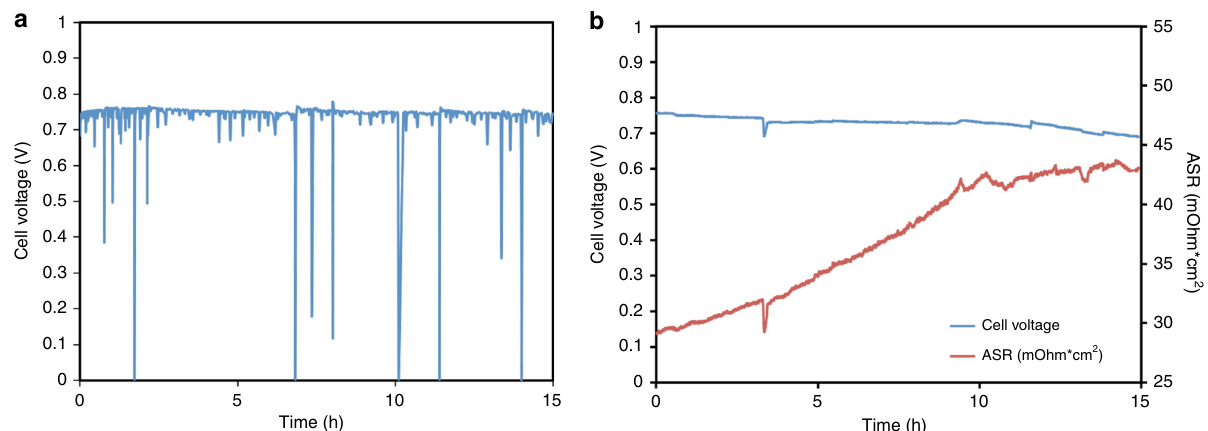
Fig. 5 AMFC stability at high and low water conditions. a Cell stability under relatively high anode/cathode dew points of 55/60 °C; ( b ) cell stability under optimized anode/cathode dew points of 53/55 °C. During the test, the cell voltage and ASR were recorded. The cells were constructed with a PtRu/C anode at 0.70 mg PtRu cm − 2 , a Pt/C cathode at 0.60 mg Pt cm − 2 , and a radiation-grafted ETFE-based AEI powder ionomer and HDPE-based AEM 5 . The cell temperature was maintained at 60 °C. H 2 /air was kept at 1.0 L/min for anode/cathode, respectively. The cell current density was kept at 600 mA cm − 2 . The data is presented without